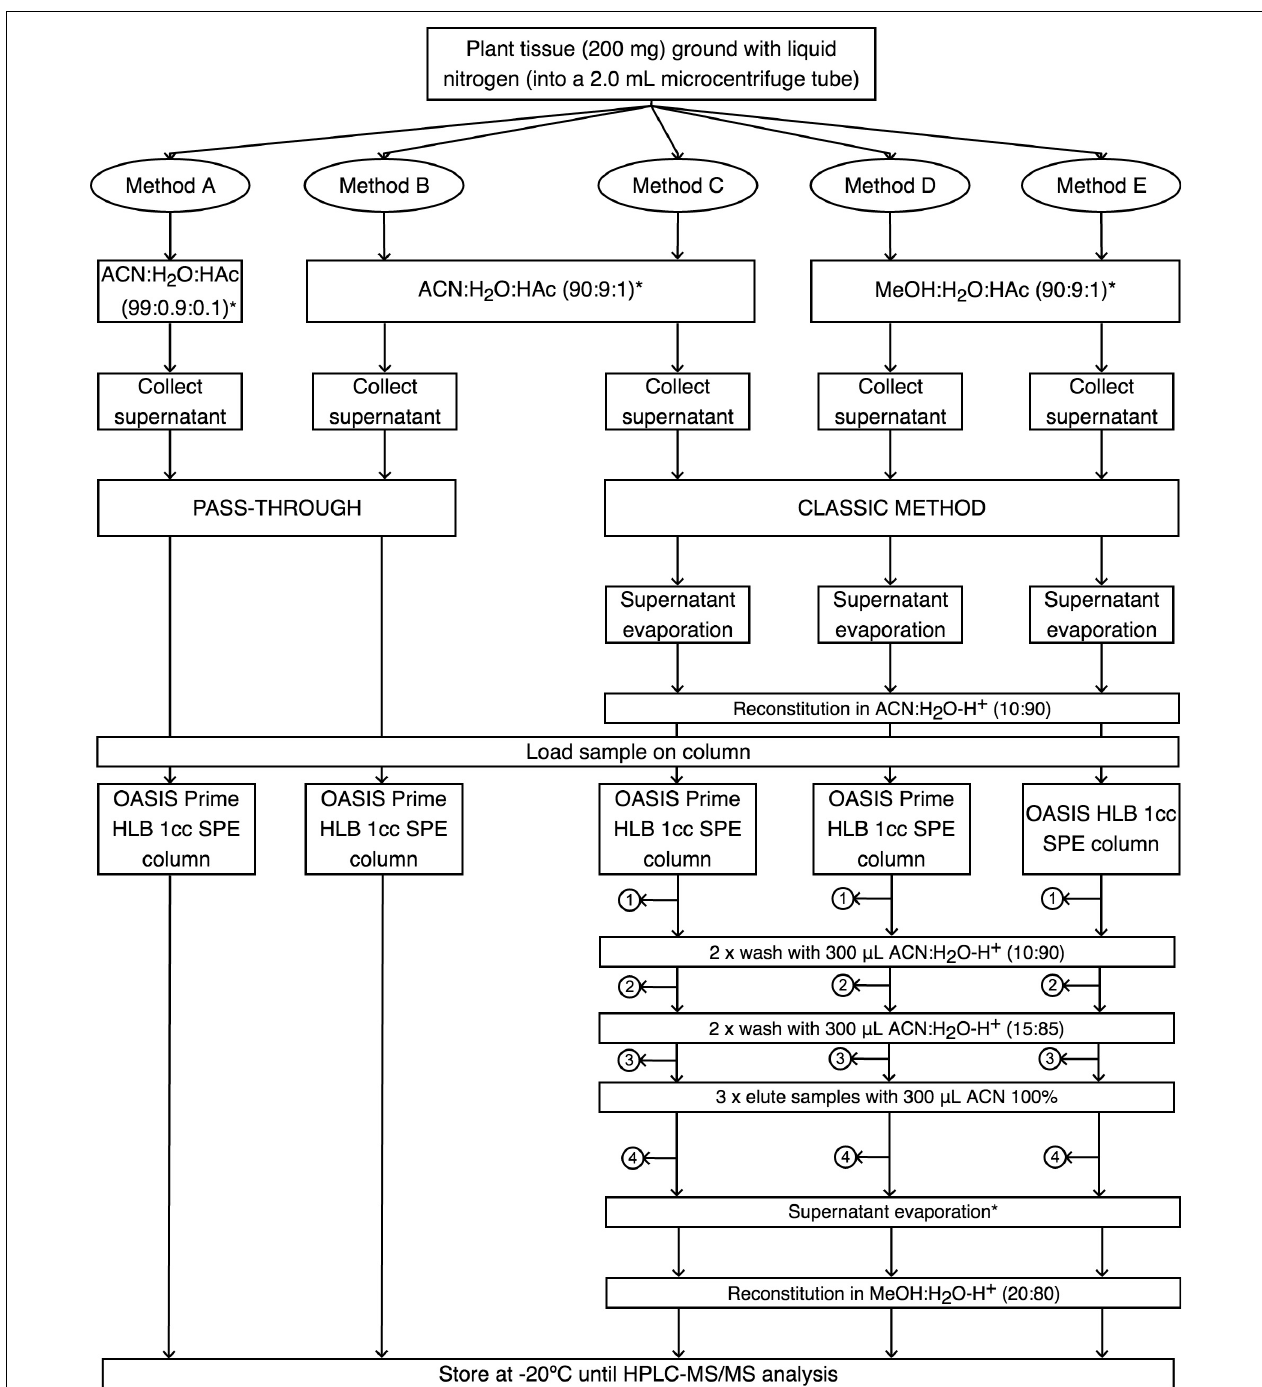
FIGURE 1 | Flow chart of the phytohormone extraction protocols. In each numbered bullet, the fraction (#1, #2, #3) and eluate (#4) were collected to detect for possible phytohormone leakage. ACN, acetonitrile; HAc, acetic acid; MeOH, methanol; SPE, solid phase extraction; ∗ , supplemented with 0.05% HAc.